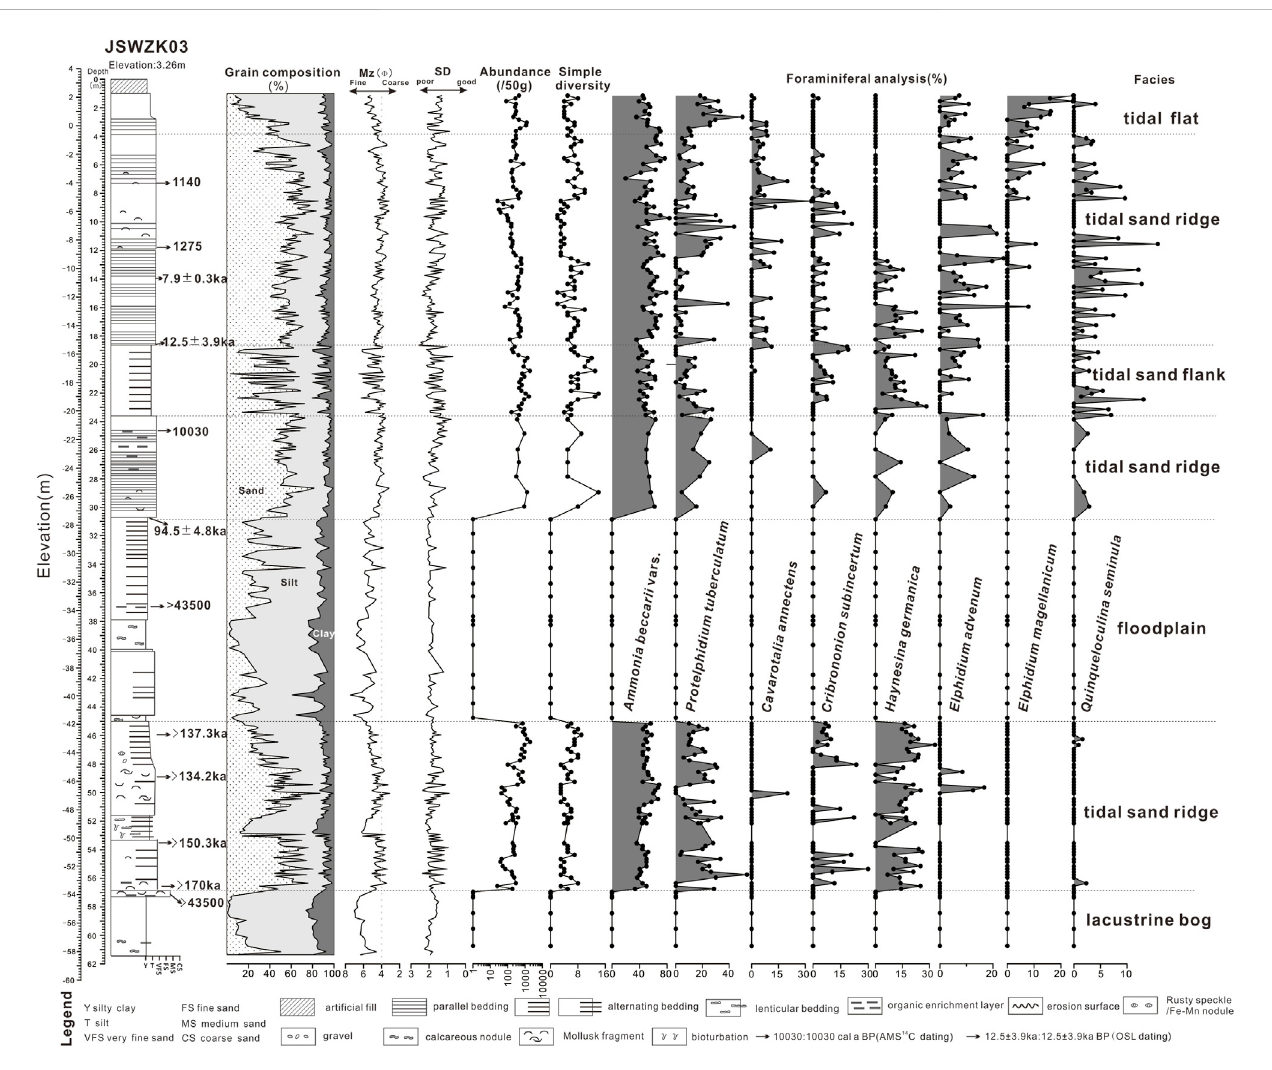
FIGURE 6 Comprehensive stratigraphic log of the core JSWZK03, showing lithology, grain size, and foraminiferal content. The borehole is divided into fi ve sedimentaryfaciesfromtheLatePleistocenelacustrinebog,tidalsandridge,and fl oodplaintotheHolocenetidalsandridge,tidalsand fl ank,andtidal fl at.Itis to be noted that the OSL ages are older than 130 ka BP below the depth of 45 m, indicating an age-unconstrained strata in this borehole. For more detailed foraminiferal data, see Supplementary Table S2 in the